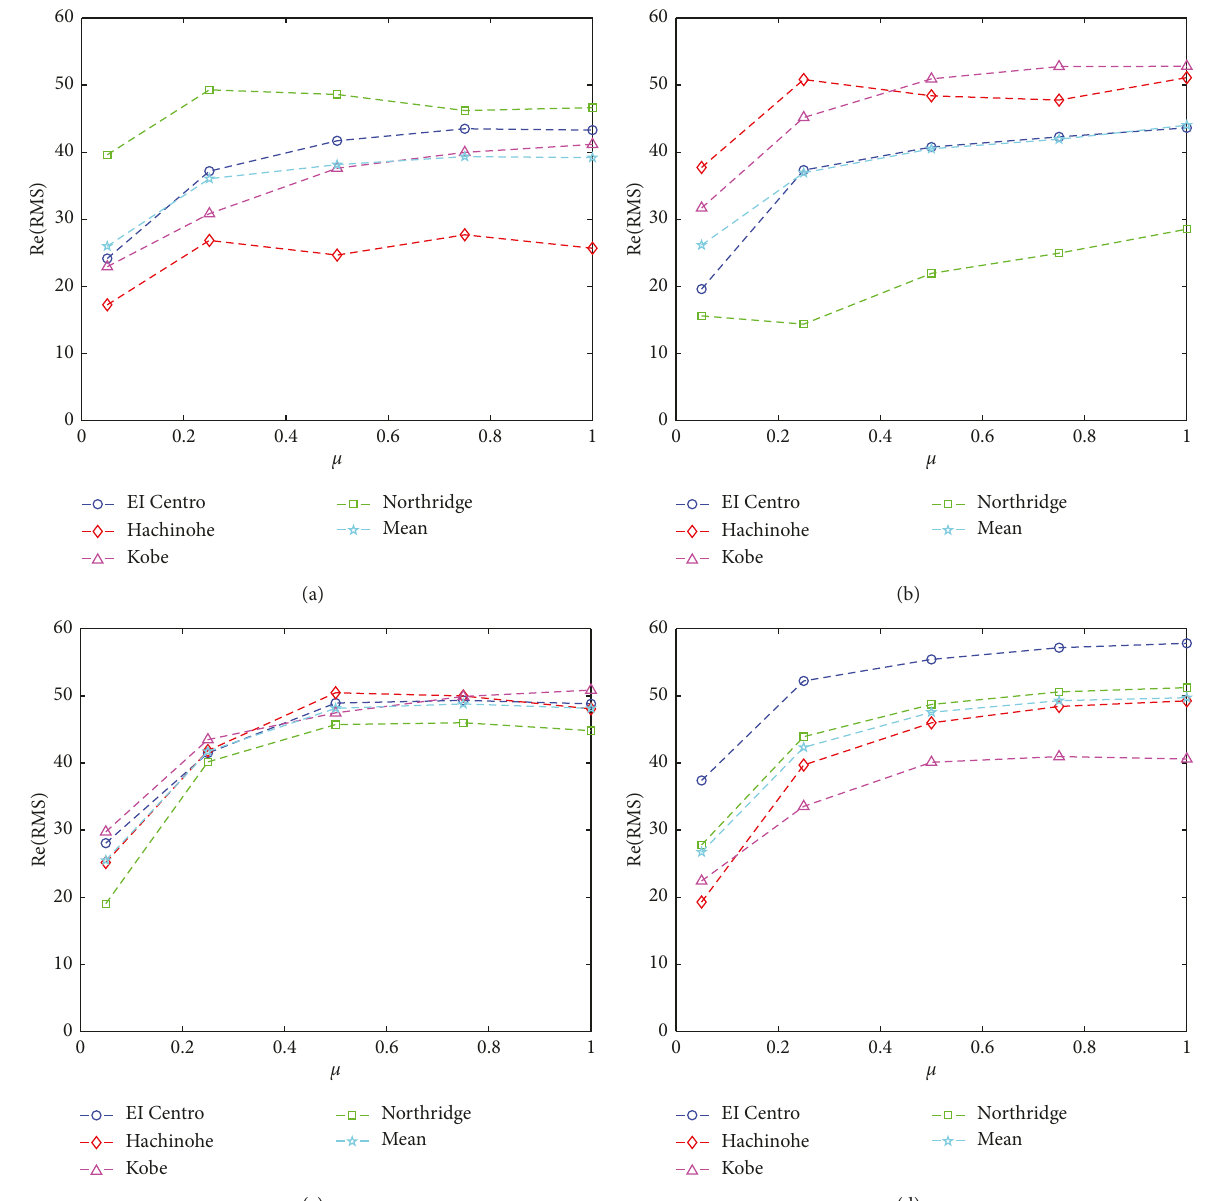
Figure 13: The damping effect of different mass ratios (TMD) on the mean square root of structural displacement response. (a) T T 1.0s. (c) T 2.0s. (d) T (cid:31) (cid:31) (cid:31)